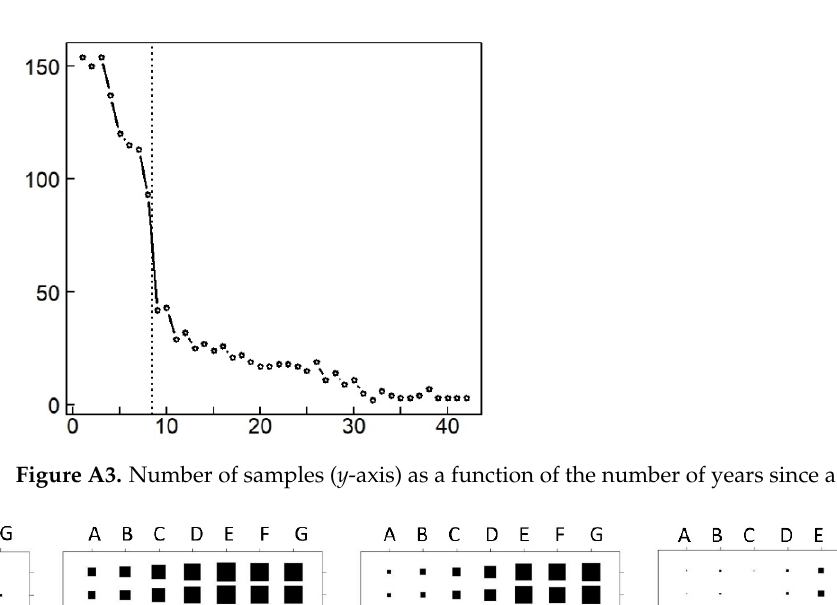
Figure A2. Proportions of open habitats and forest habitats (as percentages of the study area) at three dates from 1953 to 1994. From Sébastien Tomas (unpublished results).